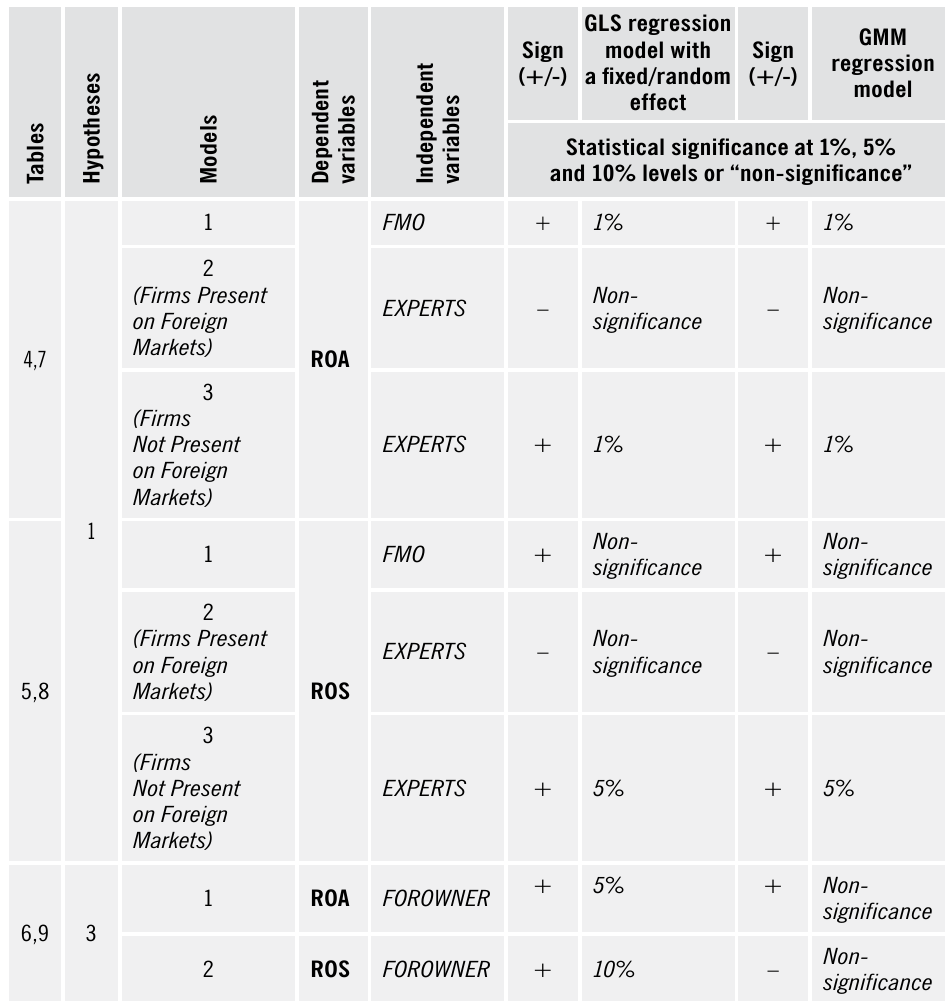
Table 13. The comparison of the static GLS regression model with a fixed or random effect & dynamic GMM panel regression model